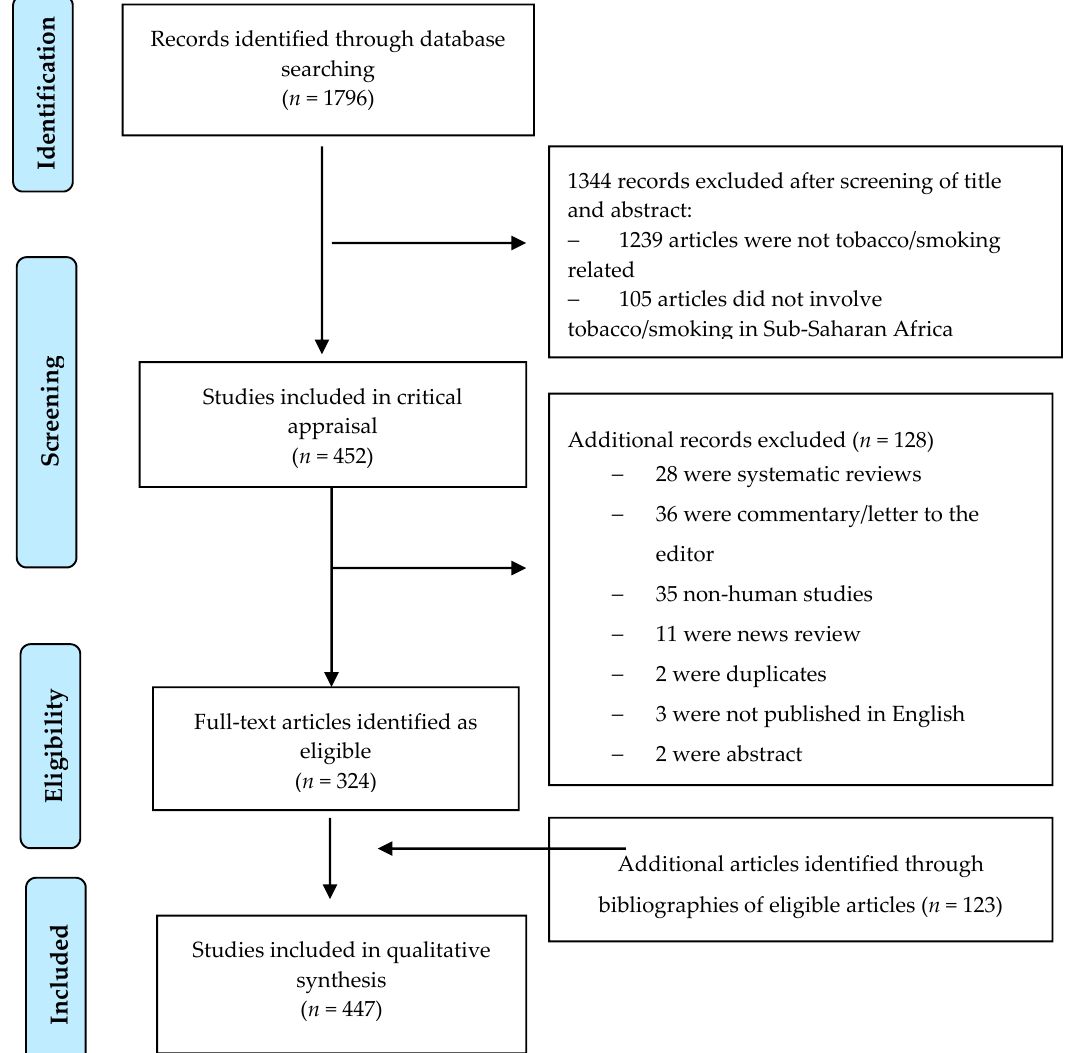
Figure 1. Flow Diagram.